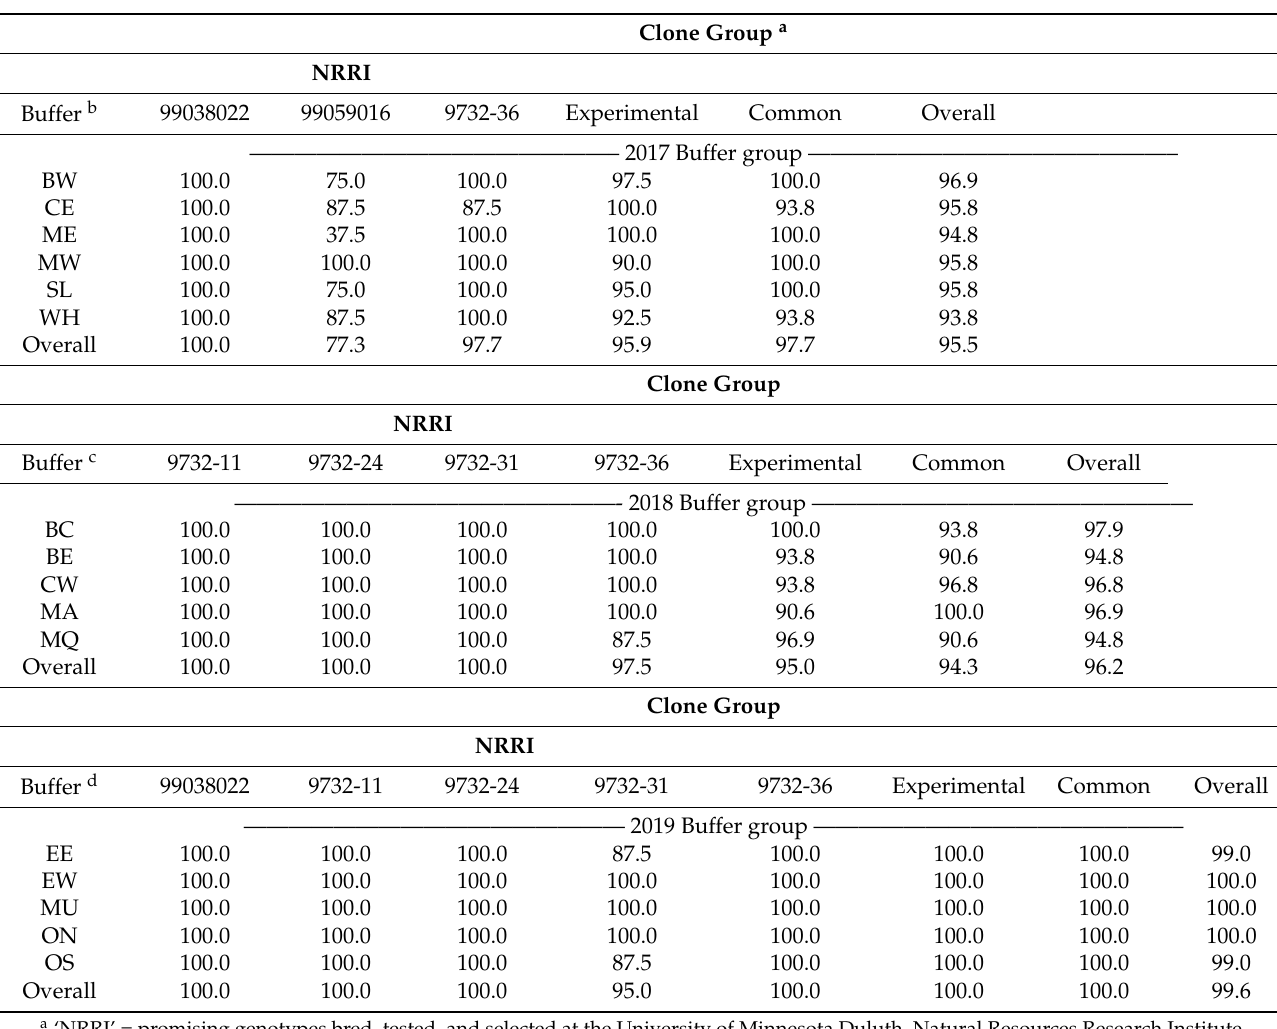
Table 4. First-year survival (percentage) of three poplar clone groups tested in sixteen phytoremediation buffer systems (i.e., phyto buffers) that were established in 2017, 2018, and 2019 (i.e., buffer groups) in the Lake Superior watershed of the Upper Peninsula of Michigan, USA and the Lake Michigan watershed of eastern Wisconsin,